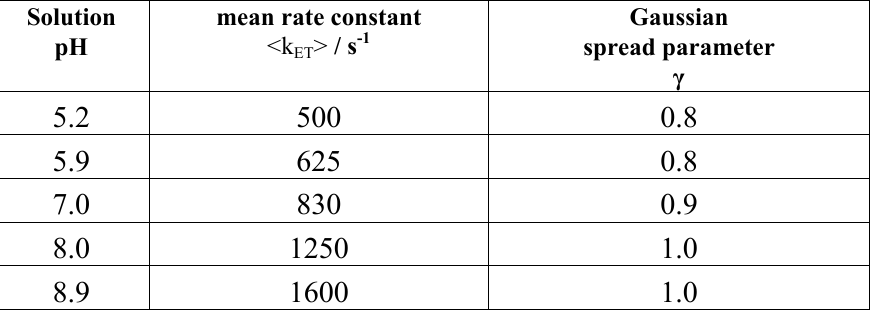
ET kinetics as function of solution pH. 2